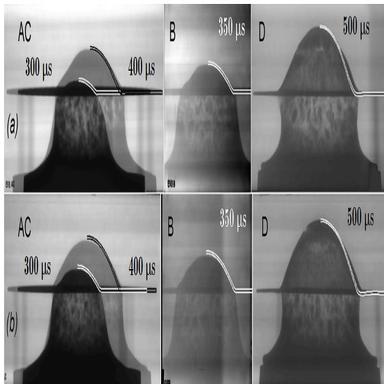
Experimental flash X-ray results and comparison with the calculations (shown as half plate black and white contours) for the as-received fine silica sand loaded by the configuration U charge, ρ0 = 1.57 g/cm3 (a) and configuration V charge, ρ0 = 1.57 g/cm3 (b).